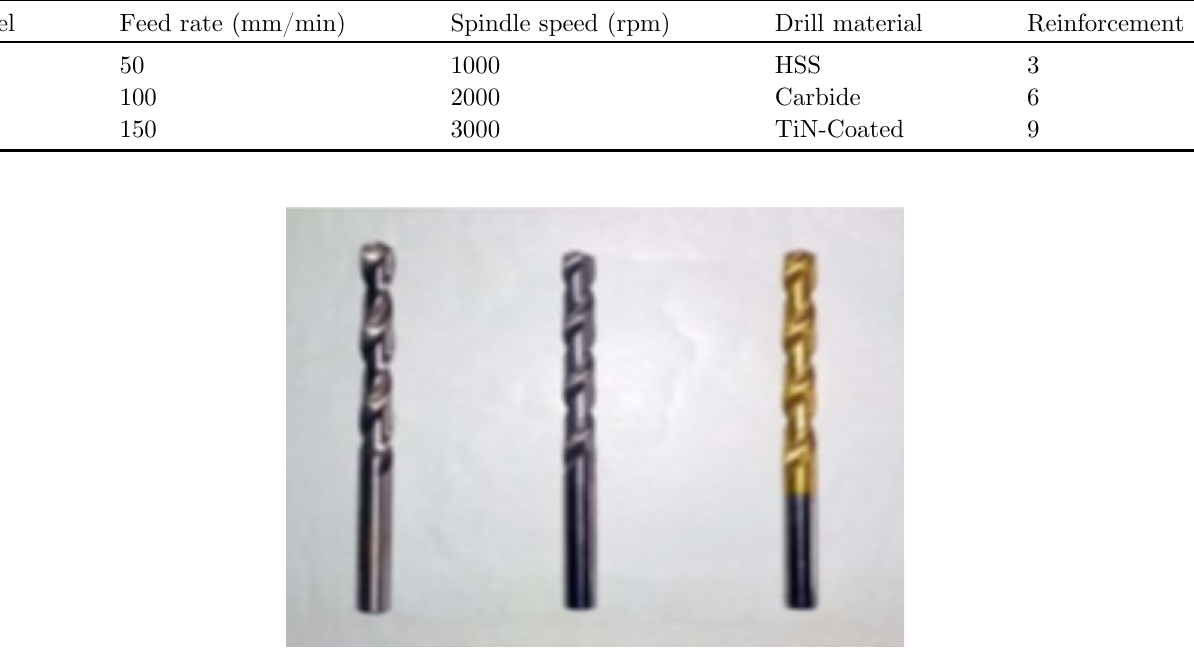
Fig. 5. Photograph of